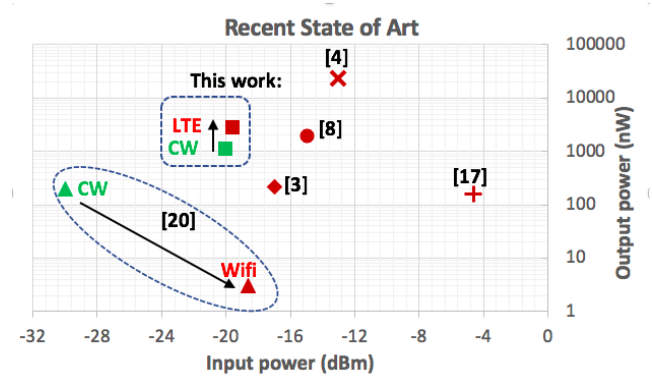
Figure 27. Recent state-of-the-art in ambient RF energy